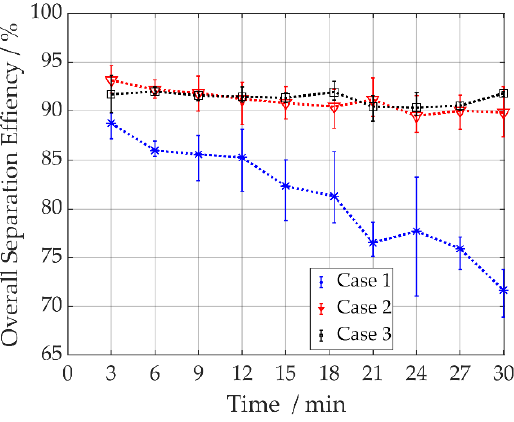
Figure 6. Overall separation efficiency for the three cases over time. Blue: 20,000 rpm; Red: 40,000 rpm; Black: Increasing rotational speed. Squares: Mean values; bars: Minimum/maximum of the three repeating experiments; dashed lines are guides to the eye.